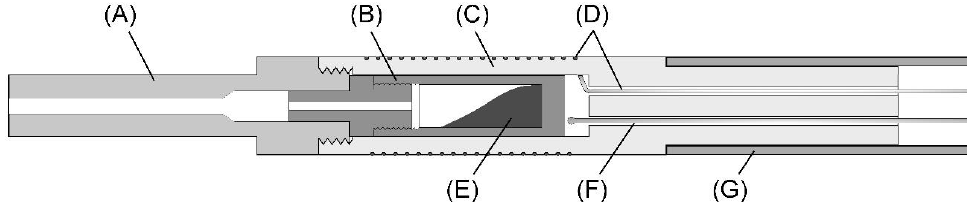
Figure 3. Cross section of the oven rod. ( A ) Tungsten nozzle: the inner diameter of 2 mm. ( B ) Carbon crucible. ( C ) Ceramic insulator (BN). ( D ) Ta wire: spirally wounding along the groove on the surface of the ceramic insulator. ( E ) C 60 powder sample. ( F ) Thermocouple. ( G ) Half-inch diameter stainless-steel pipe.